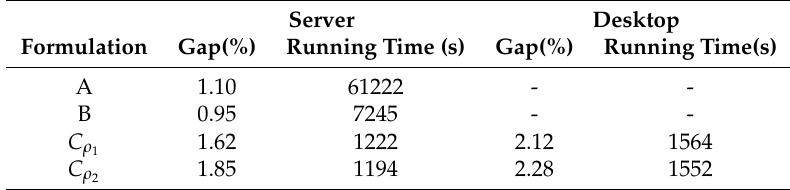
Table A1. Detailed results of the three formulations on the server and the desktop